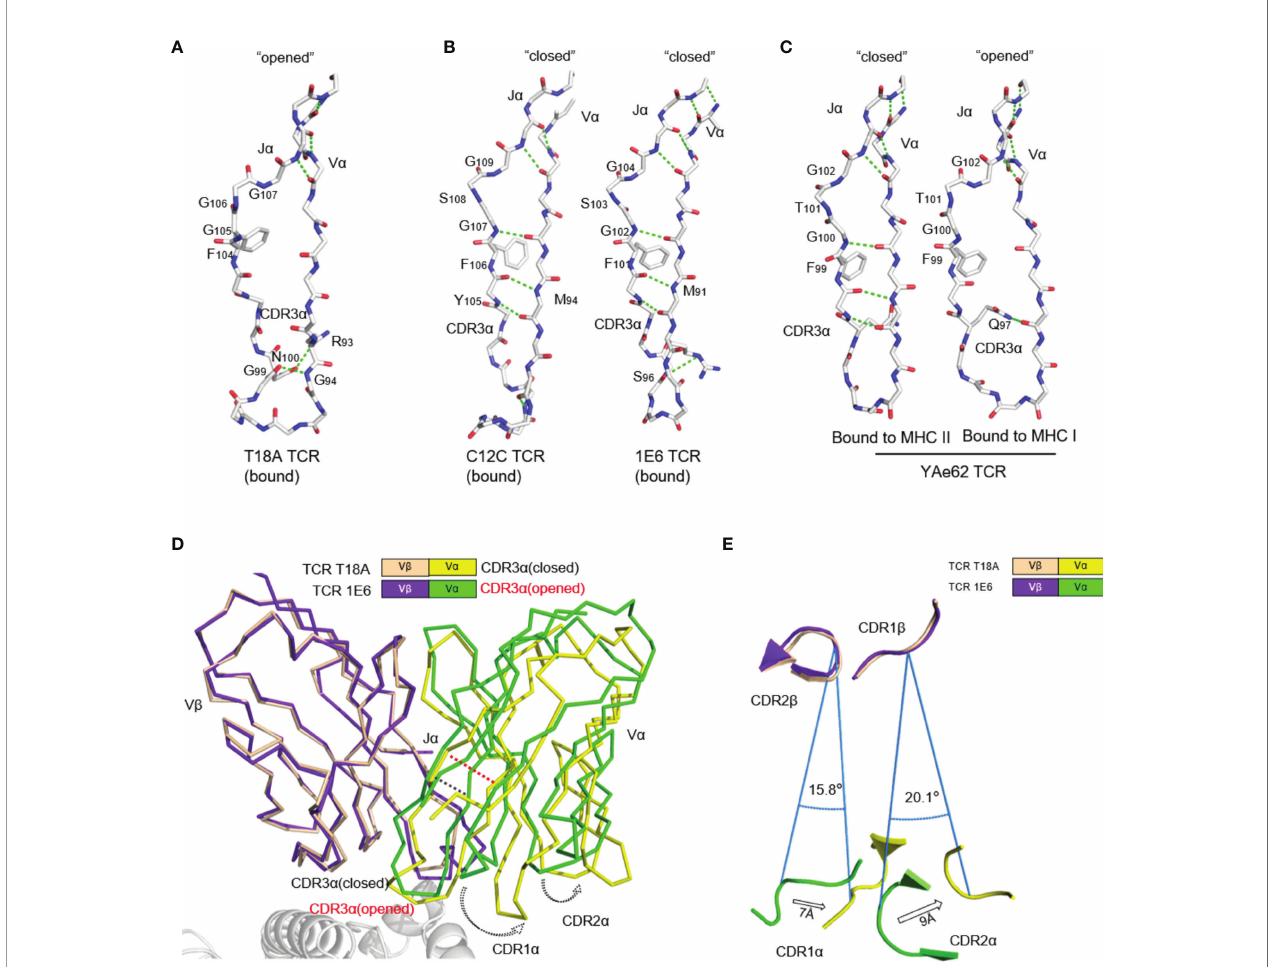
FIGURE 4 | The uncommon “ opened ” T18A CDR3 a alters the relative orientation of V a to V b . (A) The “ opened ” conformation of the b sheet interactions between V a and J a of T18A when it is bound to B8101-pTL9. A stick representation of the protein backbone and the side chains of the FGXG conserved motif are shown. Backbone H-bonds, as well as H-bond with R93, are shown in green. (B) The “ closed ” conformation of V a -J a interactions of C12C TCR (PDB: 4G8G) and 1E6 TCR (PDB: 3UTS), representing traditional CDR3 a conformation in most of TCR-pMHC pro fi les. (C) The disruption of V a -J a H bonds of YAe62 (PDB: 3C60) when it is bound to MHC II versus MHC I, indicating the alteration of CDR3 a could expand the ability of the TCR to adapt Different MHC Ligands. (D) The V a and V b domains of T18A and 1E6 TCR are overlaid by V b as similar TRBV gene is used. (E) A view looking down through the TCR is shown. Relative position of CDR a loops to CDR b loops are changed due to “ opened ” or “ closed ” CDR3 a . The relative distance and angle of movement is